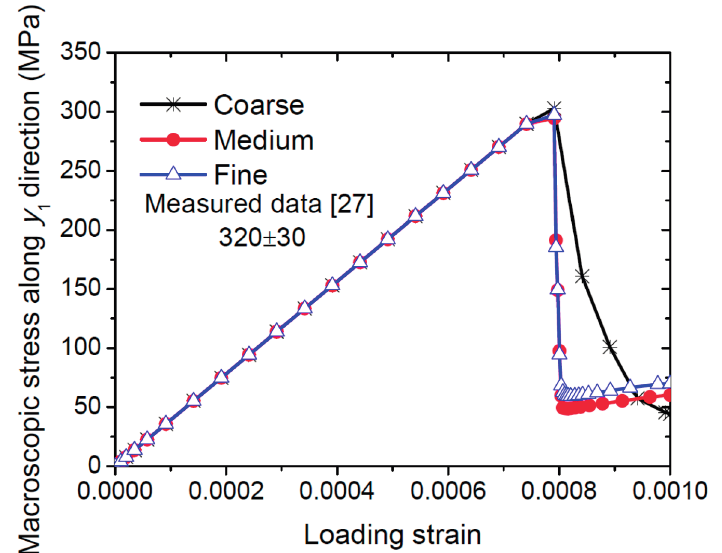
Figure 4. Influence of the mesh size on the macroscopic response of C/SiC composites subject to uniaxial tension along y 1